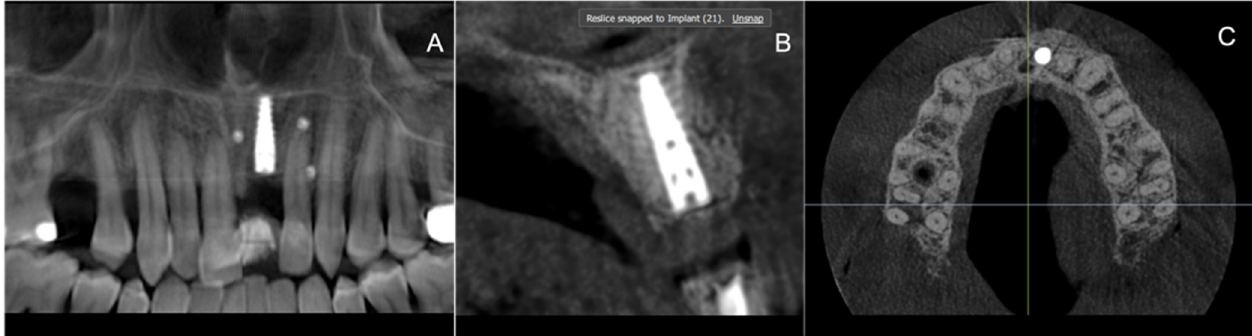
Figure 4. Post-operative radiographic images: ( A ) opt; ( B ) sagittal section of CBCT; ( C ) axial section of CBCT.